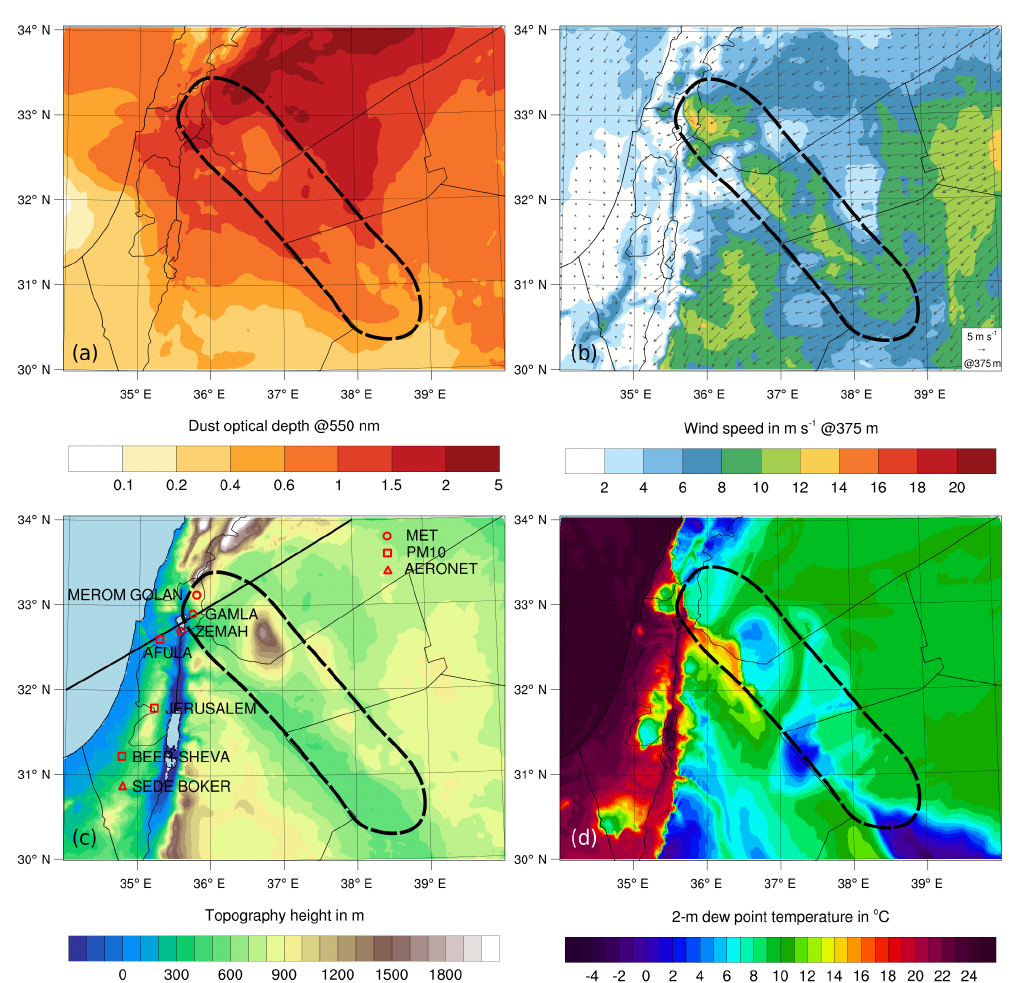
Figure 9. ICON-ART model results at 03:00UTC, 8 September. Displayed are (a) DOD at 550nm; (b) wind speed at 375m model height and wind velocity as vectors; (c) the orography in the region (colour-coded); (d) 2m dew point temperature. The dashed black line marks the region where supercritical flow conditions and the subsequent hydraulic jump occur. The solid black line in (c) shows the location of the ICON-ART vertical transect displayed in Fig. 10. In addition, the location and the names of stations used for comparison of results are